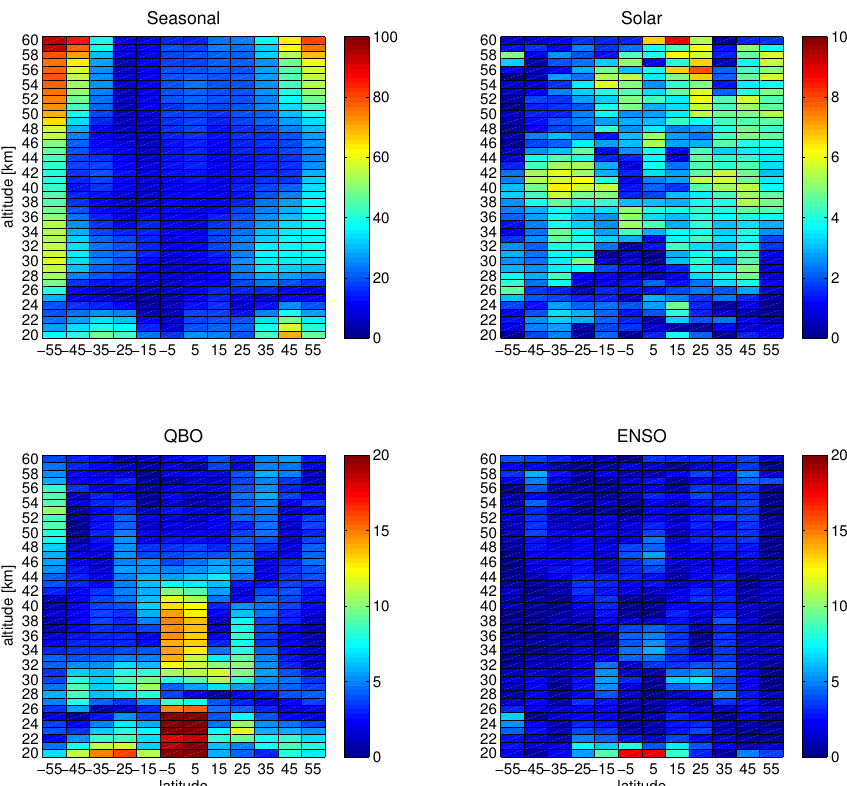
Figure 5. The effects of seasonal variation and of the proxy index variables on the variability of ozone. Here 100% means the observed standard deviation of ozone at each latitude altitude bin. The colouring corresponds to the range of variability during the whole observation period 1984–2011 of each model component given as percentages with respect to the total variability in ozone. We see, e.g. that the ENSO index significantly affects the ozone variability only at 20 km near the equator, where the effect is about 20%, also shown in the lowest panel of Fig. 3. The maximal solar effect is always less than 10%. Note that the colour scales differ.